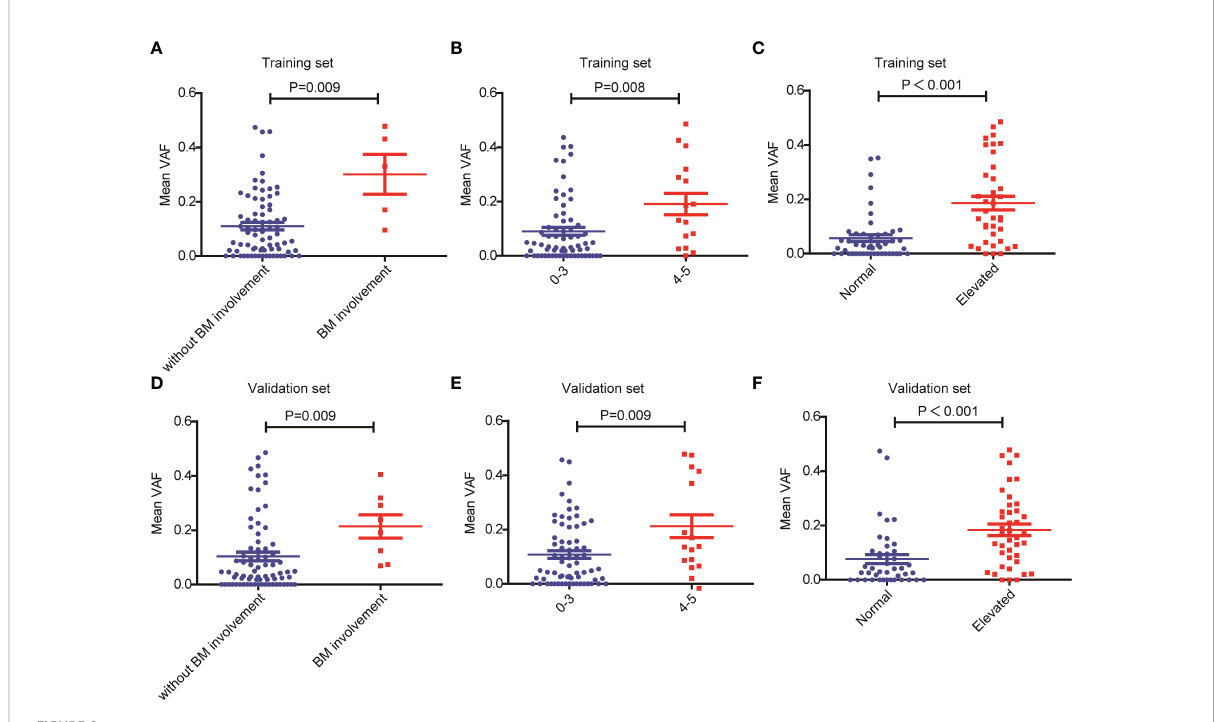
FIGURE 2 Relationship between mean VAF and clinical features in patients with newly diagnosed DLBCL. Mean VAF was increased in patients with (A, D) bone marrow involvement, (B, E) higher IPI scores and (C, F) elevated LDH levels in the training and validation